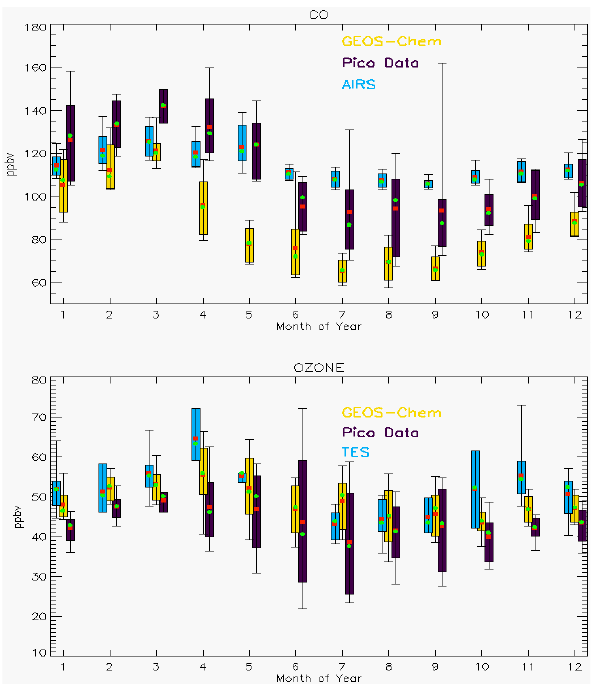
Fig. 5. Regression model fit to the PMO observations for CO (top) and O 3